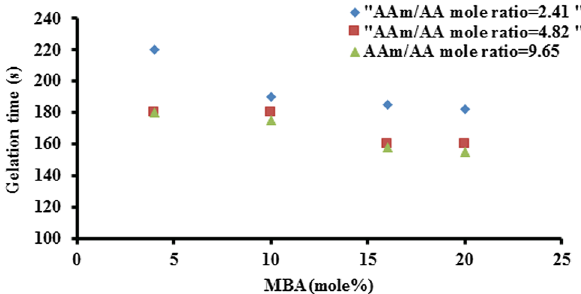
Fig. 1 Fourier transform infrared spectrum of sample 1